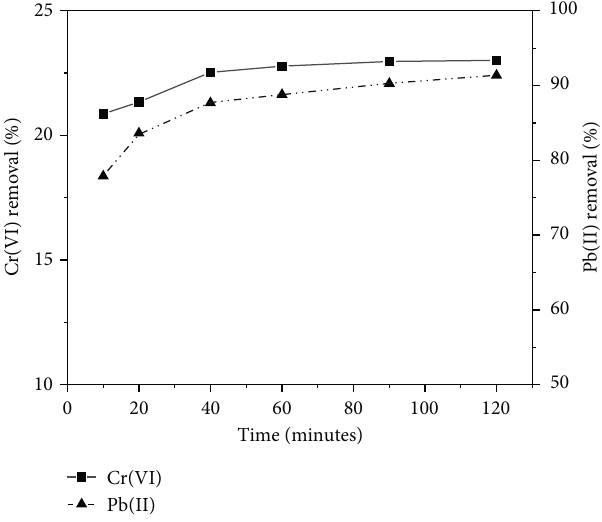
Figure 3: Removal of chromium and lead as a function of time by using RHA-based zeolite